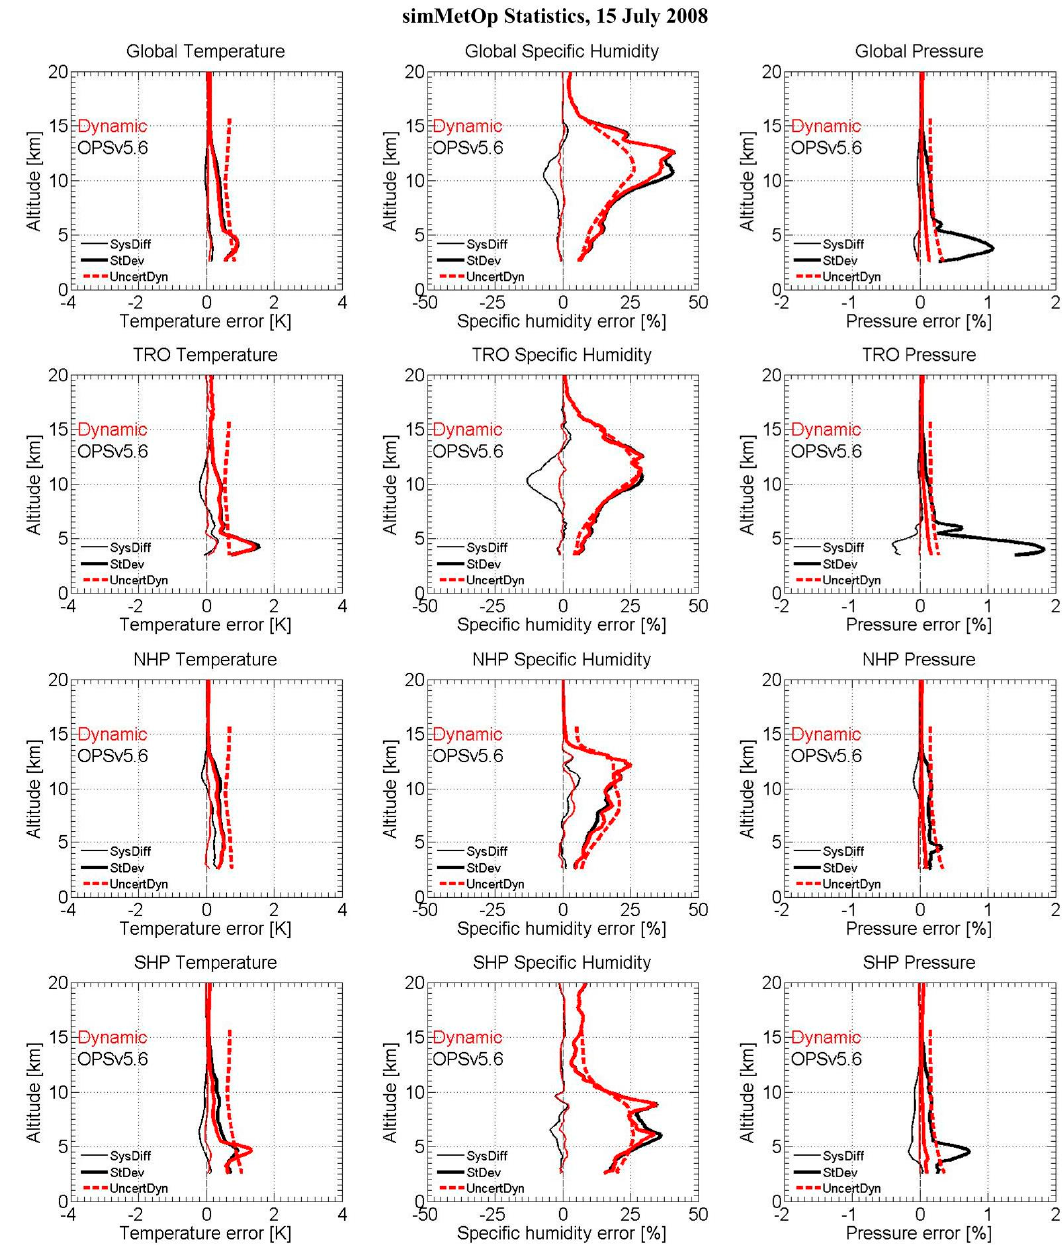
Figure 7. Systematic differences (SysDiff) and standard deviations (StDev) of retrieved temperature (left column), specific humidity (middle column), and pressure (right column), relative to ECMWF co-located analysis profiles as reference, of the ensemble of simMetOp events on 15 July 2008. Statistics for both the dynamic (red) and OPSv5.6 (black) approach are shown for four representative regions (top to bottom: Global, TRO, NHP, SHP). The propagated uncertainties of retrieved profiles from the dynamic approach (UncertDyn; red-dashed) are shown as well.